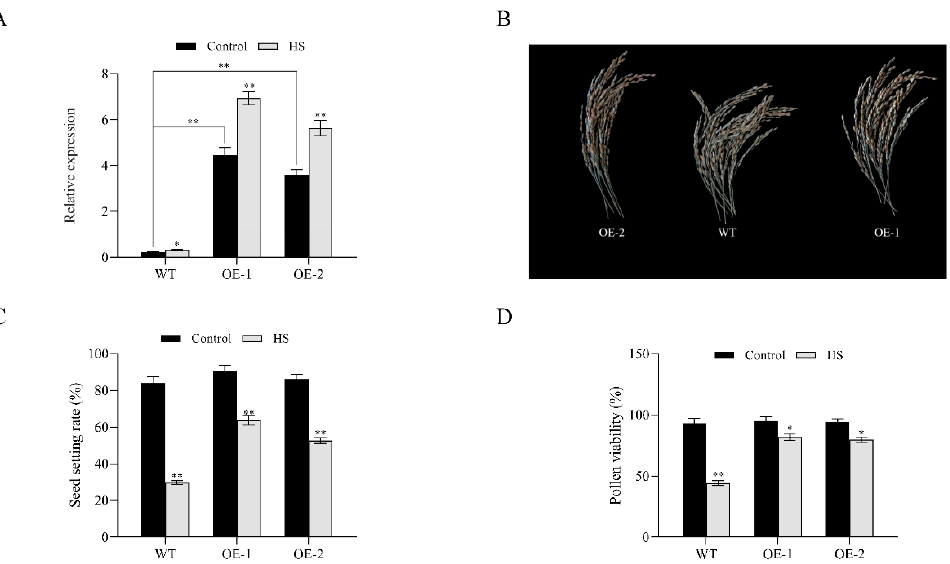
Figure 6. Relative expression of OsNCED1 in OE-1, OE-2, and WT under HS (37 °C day/30 °C night) and control on the fifth day ( A ). Seed setting rates of OE-1, OE-2, and WT under HS (37 °C day/30 °C night) and control on the fifth day ( B , C ). Pollen viability of OE-1, OE-2, and WT under HS and control on the fifth day ( D ). Data shown are means ± SD of three independent experiments. * Significance at p < 0.05. ** Significance at p < 0.01, as determined by Student’s t -test ( n = 3).